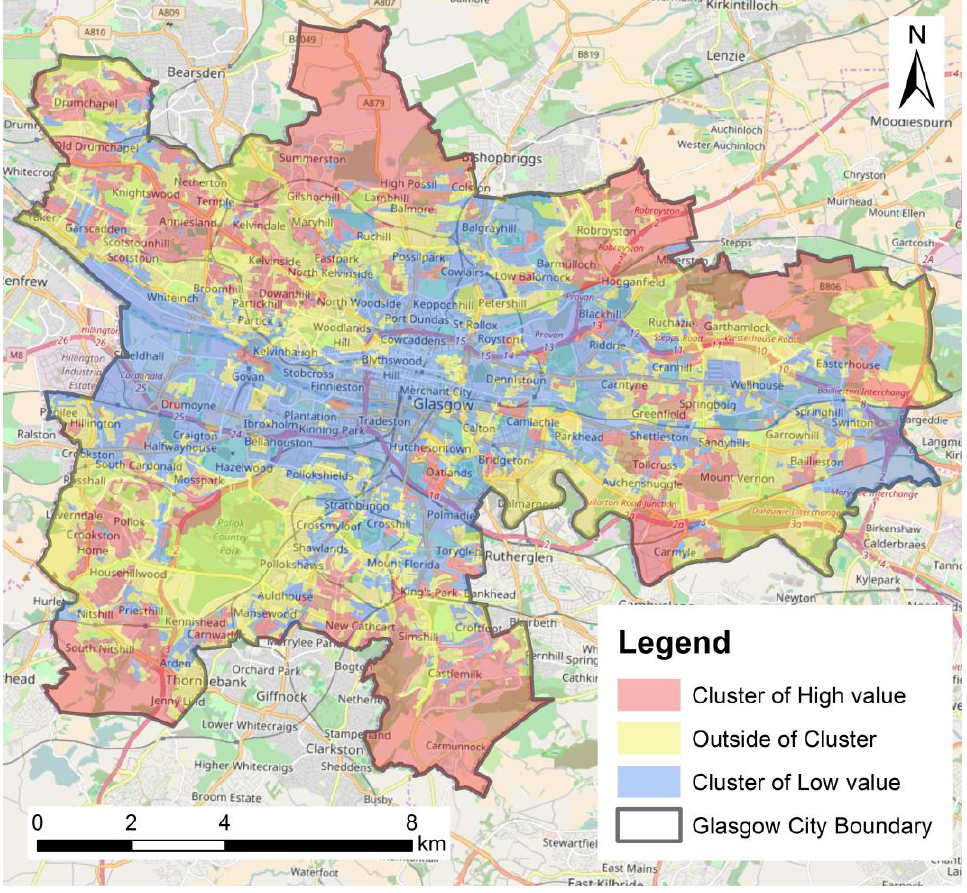
Figure 5. Clusters of high and low non-commuting rate.